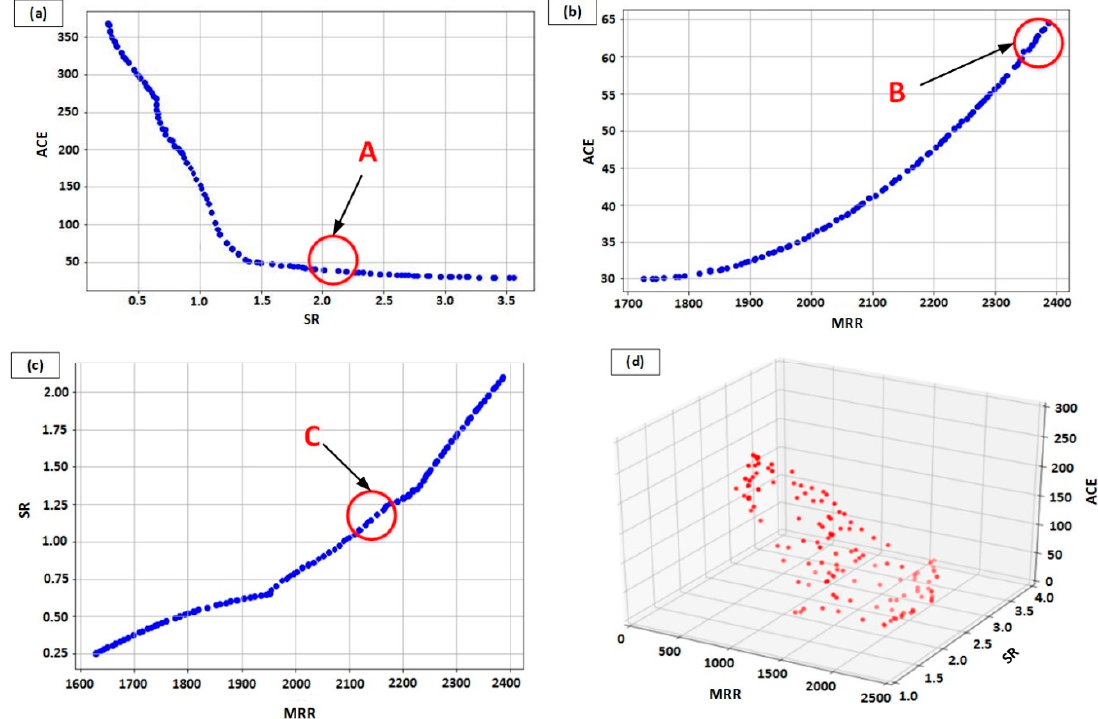
Figure 8. Pareto optimal-front for optimization objectives: ( a ) Active cutting energy (ACE) vs. Surface roughness (SR), ( b ) Active cutting energy (ACE) vs. Material removal rate (MRR) and ( c ) Surface roughness (SR) vs. Material removal rate (MRR) ( d ) 3D Pareto front.